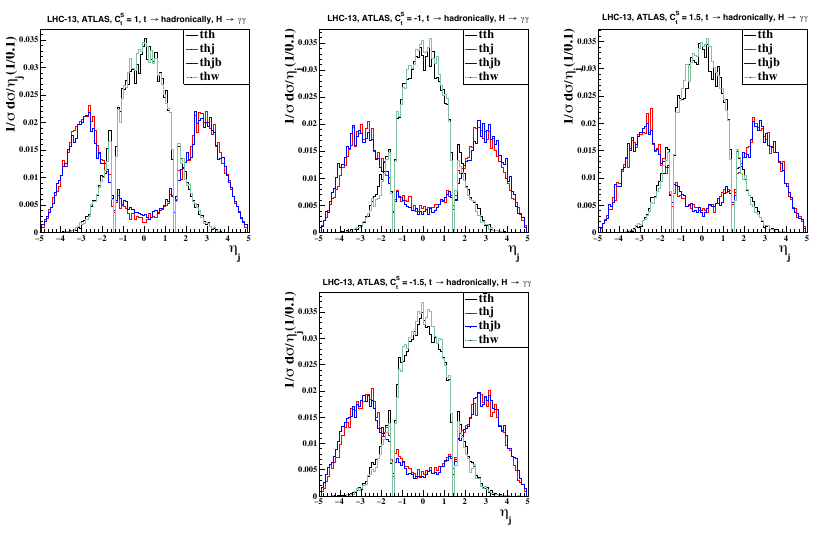
Figure 9 . The same as in (cid:12)gure 8 but for the (cid:17) j distributions. values of C S , implying that our thj -speci(cid:12)c cuts are working very e(cid:14)ciently when the thj t production cross section is much enhanced with R ( thj ) > (cid:24) 1. On the other hand, (cid:22) ( t (cid:22) th ) (right) is dominated by t (cid:22) th (blue) independently of C S and we observe that our t (cid:22) th -speci(cid:12)c t cuts are working reasonably well as in the LHC-8 case (the left panel of (cid:12)gure 6). We